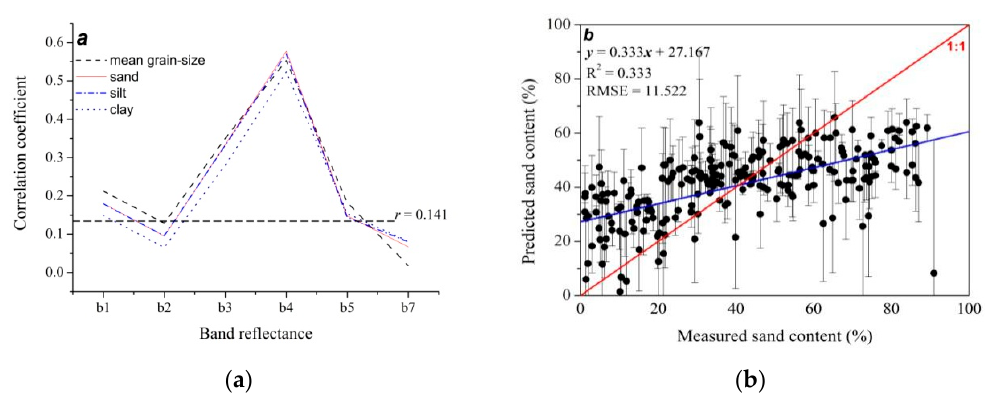
Figure 5. Correlations between the band reflectances of Landsat imagery ( a ) and the measured grain-size parameters. The linear calibration model of sand content based on the reflectance of band 4 ( b ).